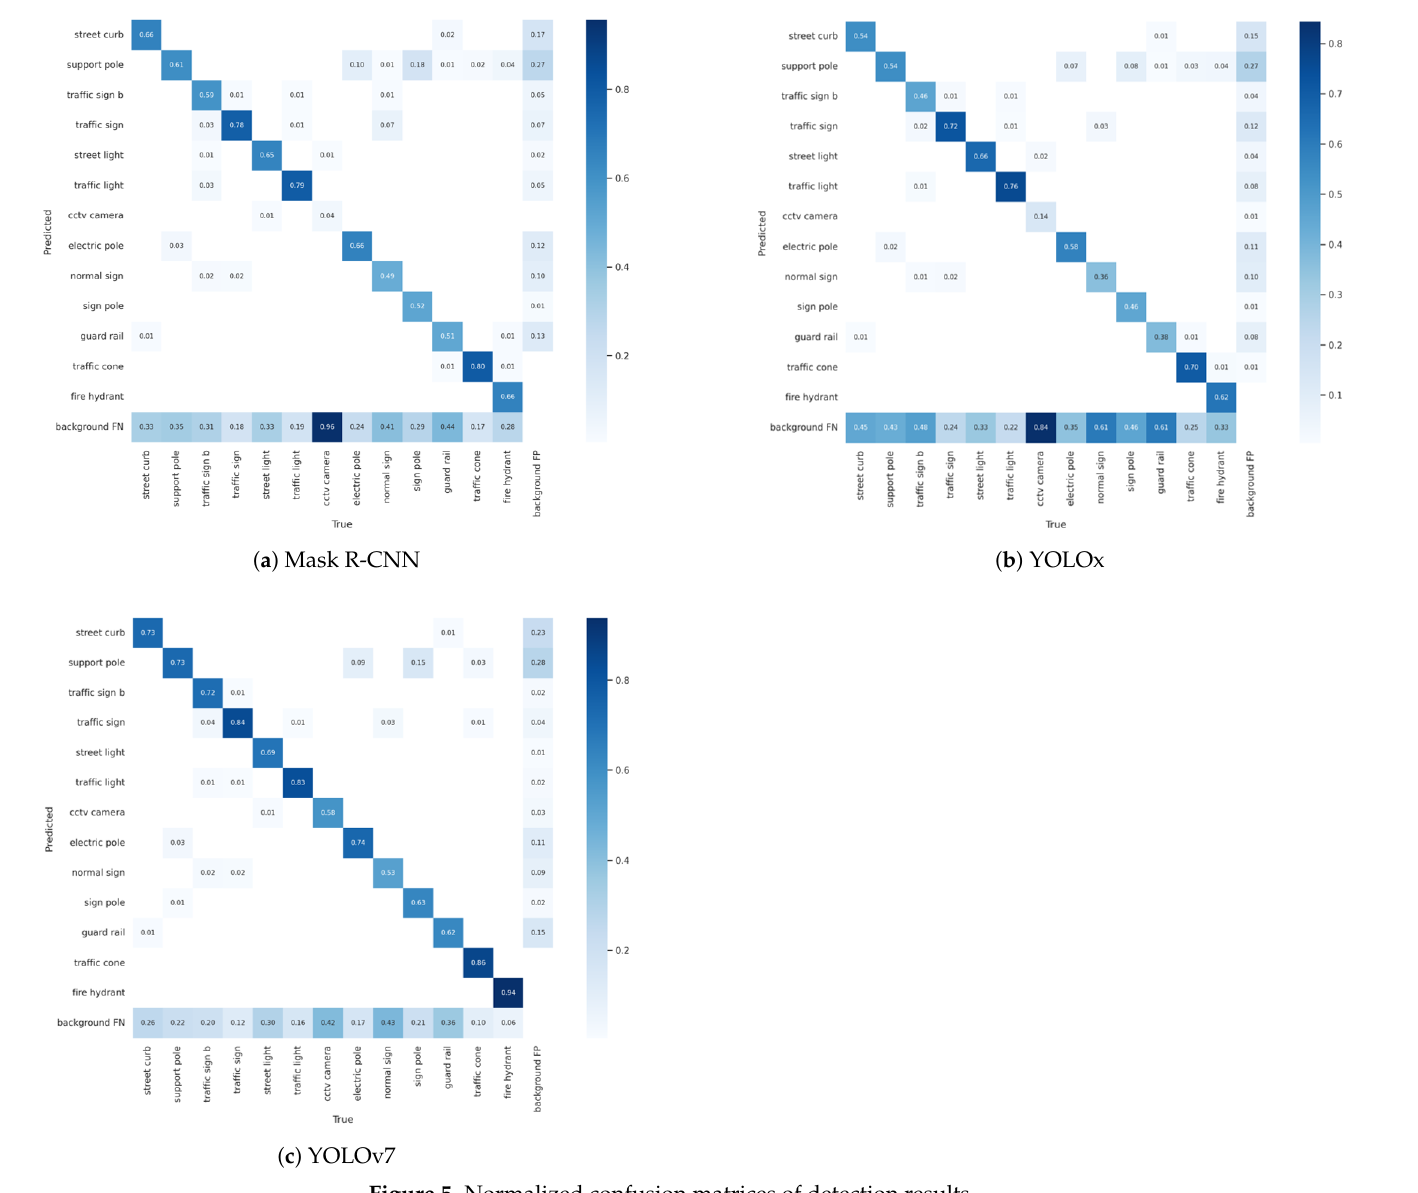
Table 1. Detection results (IoU threshold = 45%).